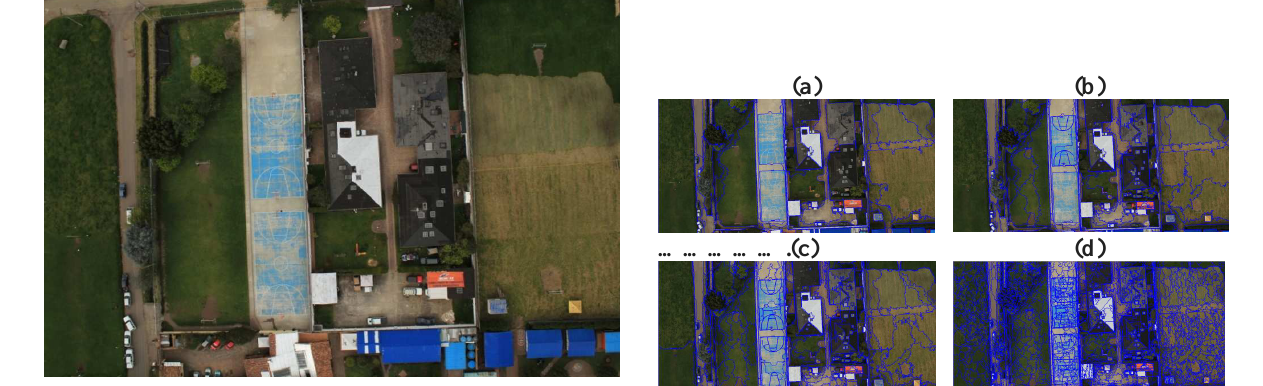
. Figure 5. Segmented air photograph, with a variation in the scale factor. Source: Elaborated by authors.